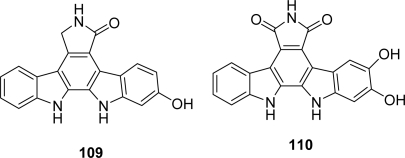
New natural indolocarbazole analogues.